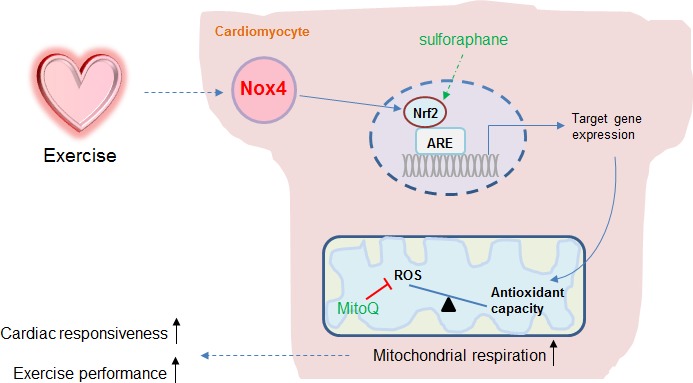
Schematic illustrating the role of the cardiomyocyte Nox4-Nrf2 pathway in enhancing mitochondrial and cardiac contractile function during acute physiological exercise.Cardiac Nox4 levels increase in response to acute exercise and induce an activation of Nrf2. The Nrf2-dependent gene program includes endogenous antioxidants that are critical in maintaining mitochondrial redox balance during peak exercise. The maintenance of mitochondrial redox balance is essential to achieve maximal mitochondrial respiration and cardiac contractile function at peak exercise. The sites of action of the Nrf2 activator sulforaphane and the mitochondria-targeted antioxidant MitoQ are shown.